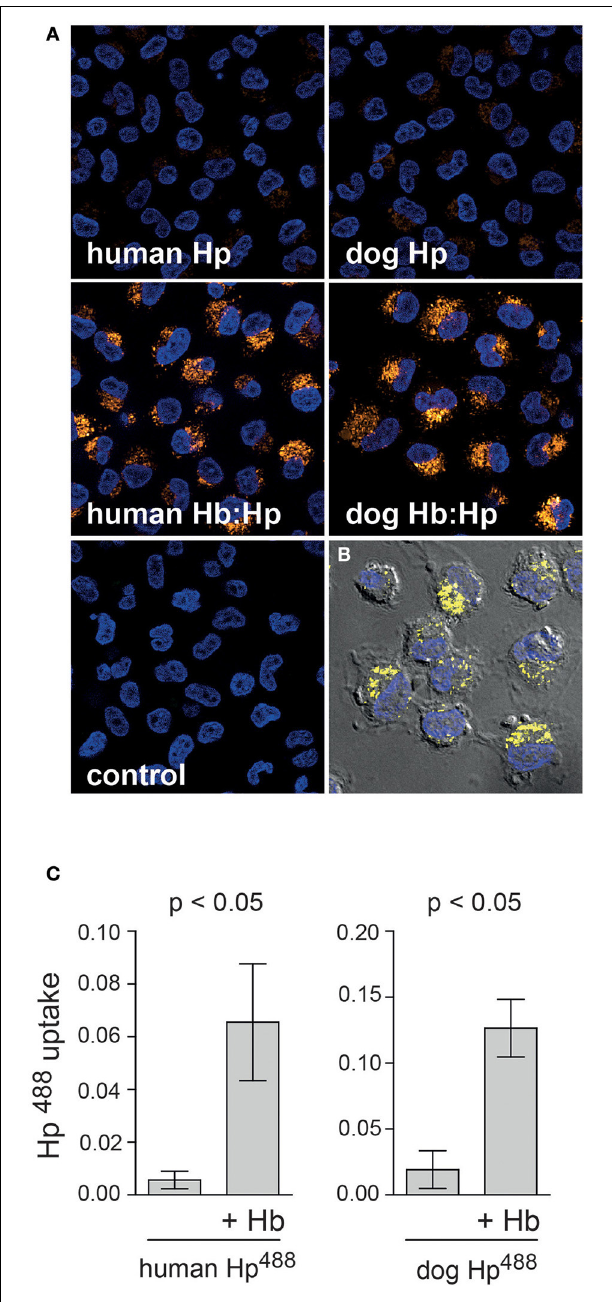
FIGURE 2 | Specificity of the dog macrophage clearance system for Hb:Hp complexes. (A) Peripheral blood CD14 + monocytes from beagle dogs were cultured for 4 days in the presence of M-CSF + dexamethasone (2.5 × 10 − 7 M) before they were incubated with fluorescent (Alexa488) dog or human Hp with or without Hb for 30min. Images are single optical sections acquired with an Apotome fluorescence microscopy system. Blue: nuclei; Orange: Hb:Hp complex. Original optical magnification 400x. (B) Fluorescence signals of a single optical apotome section as shown in (A) overlaid on a DIC bright-field image, which indicates cell boarders and intracellular localization of the endocytosed Hb:Hp complexes in the perinuclear region of the macrophages. Blue: nuclei; Yellow: Hb:Hp complex. (C) Dog and human Hp ± Hb uptake was quantified by digital image analysis in macrophages from five different beagle